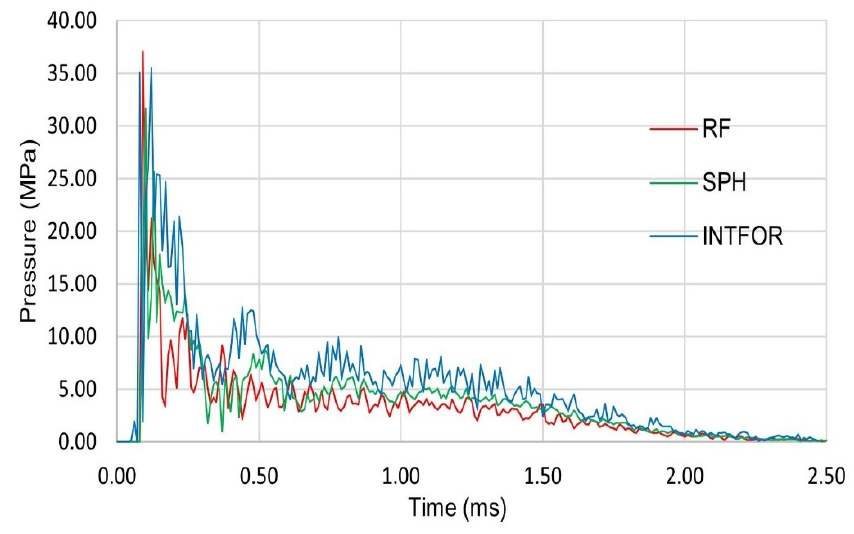
Figure 23. Pressure at center of impact for RF, SPH, INTFOR with EOS of LP_10.